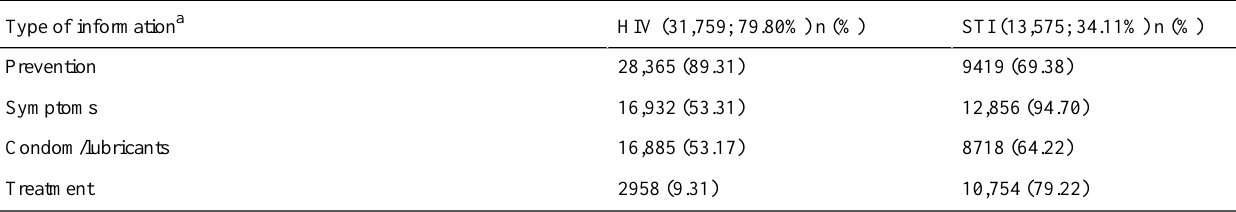
Table 2. Type of information asked on HIV and STI